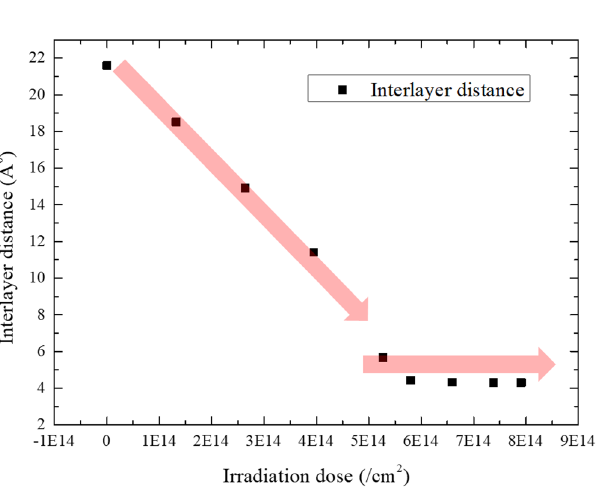
Figure 11. Reduction of interlayer distance in MoS 2 /graphene heterostructure owing to ion irradiation. The ion irradiation energy is 10 eV.